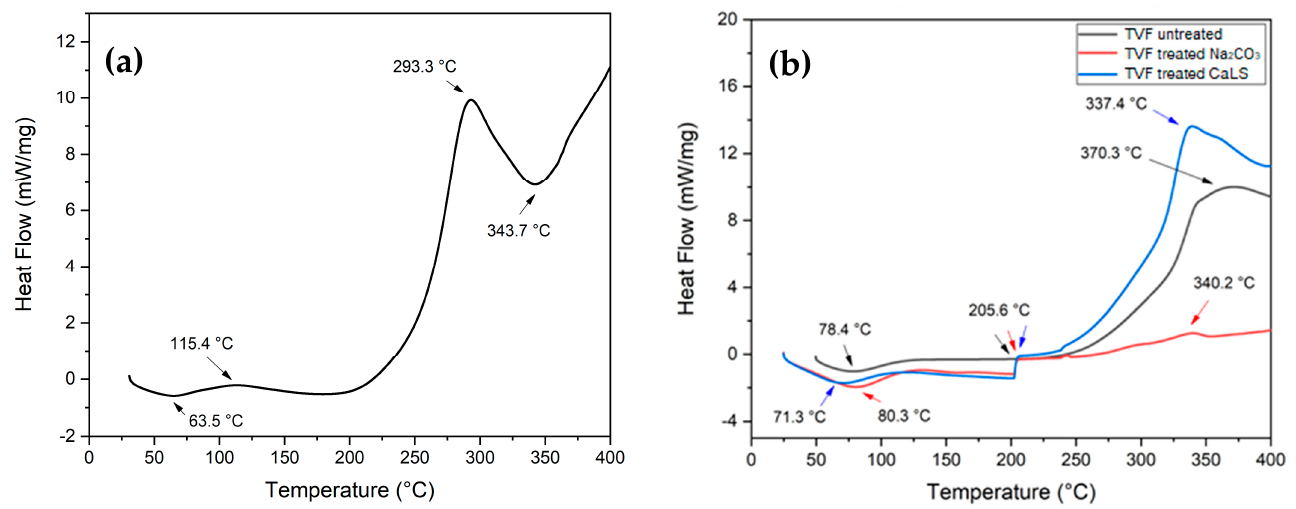
Figure 7. DSC curves for ( a ) neat epoxy resin; ( b ) untreated and treated